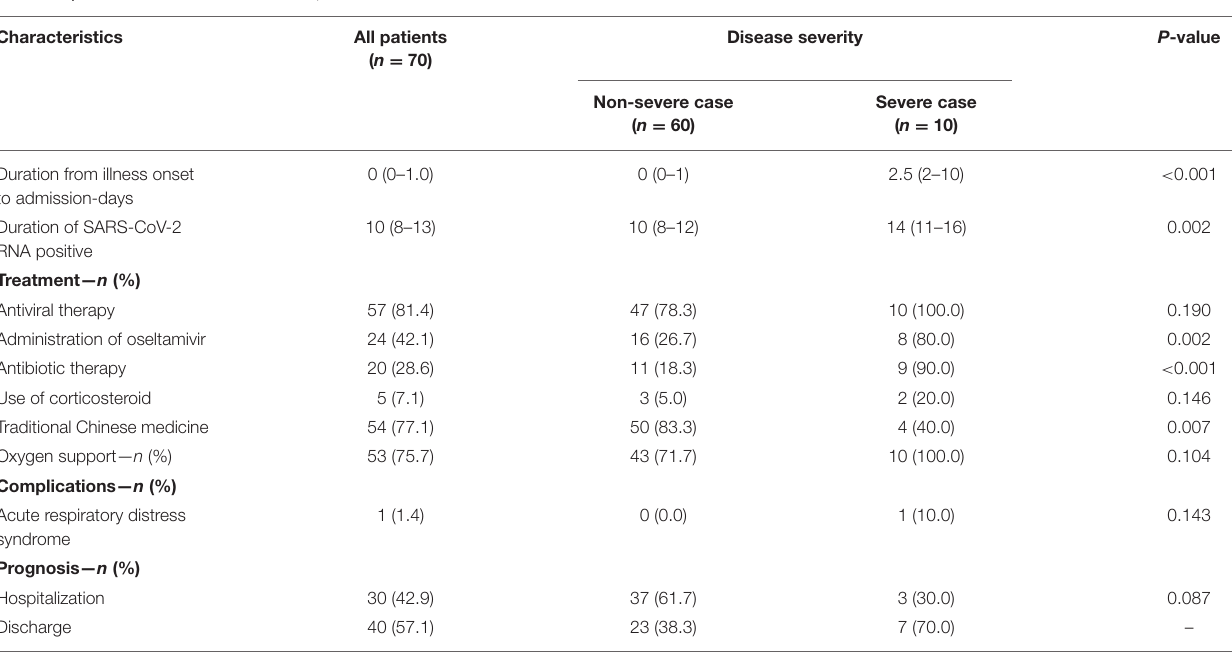
TABLE 4 | Treatment and outcomes of 70 patients with